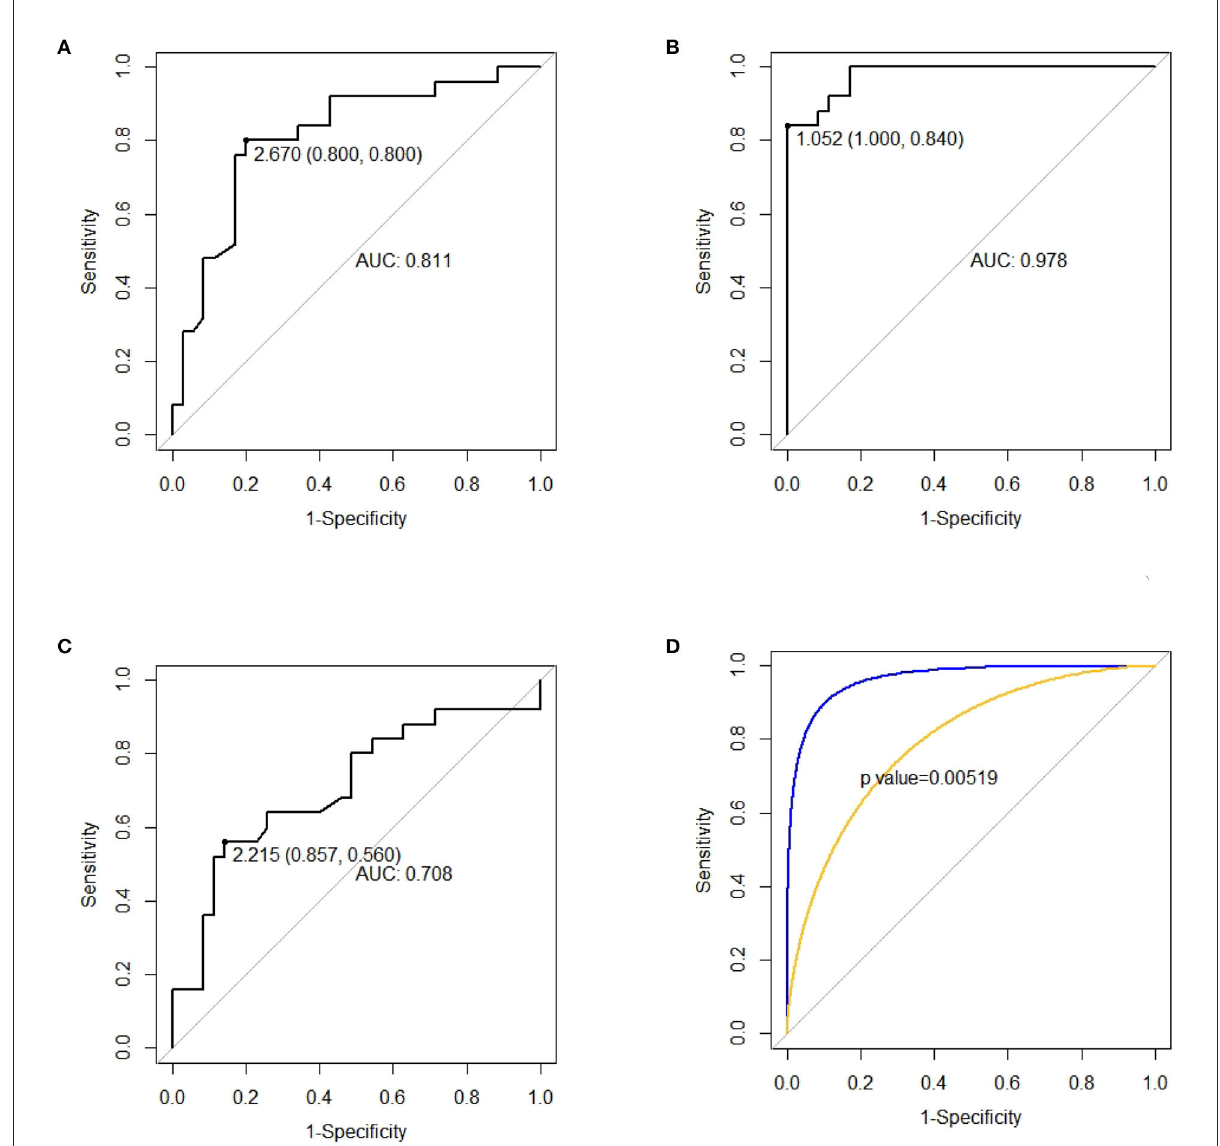
FIGURE3 ROC curves for predicting prolonged duration of mechanical ventilation (DMV). (A) CI, cardiac index, measured at T2 for predicting prolonged DMV. (B) dp/dt max , the maximal slope of the systolic upstroke, measured at T2 for predicting prolonged DMV. (C) CI, cardiac index, measured at T0 for predicting prolonged DMV. (D) Comparison between the AUC of ROC of CI and dp/dt max at